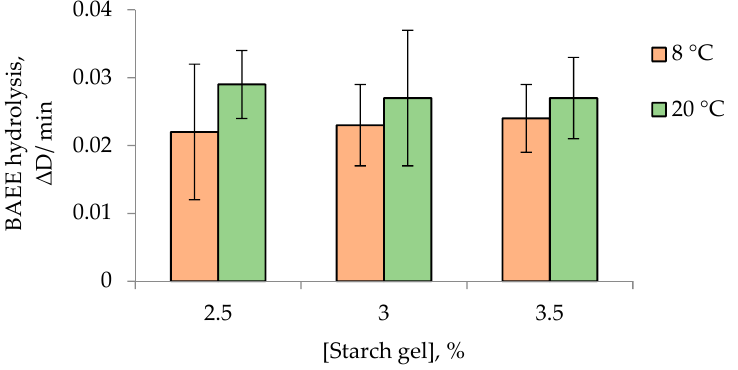
Figure 7. The rate of BAEE hydrolysis by trypsin versus concentration of potato-starch gel. Trypsin content was 11 U in the starch disks.